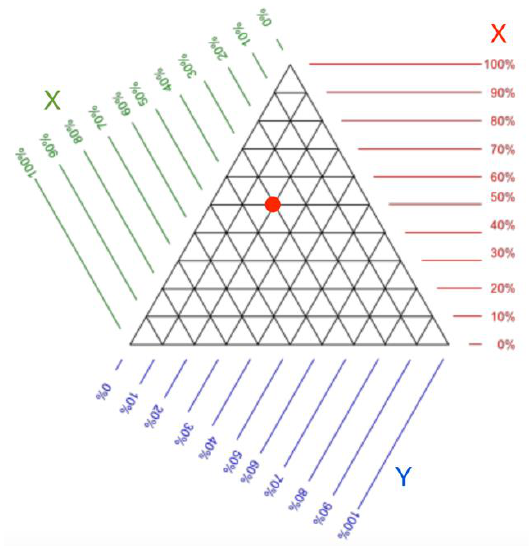
Figure 20. Trilinear coordinate pattern. It can be used to determine the value of the parameters of an